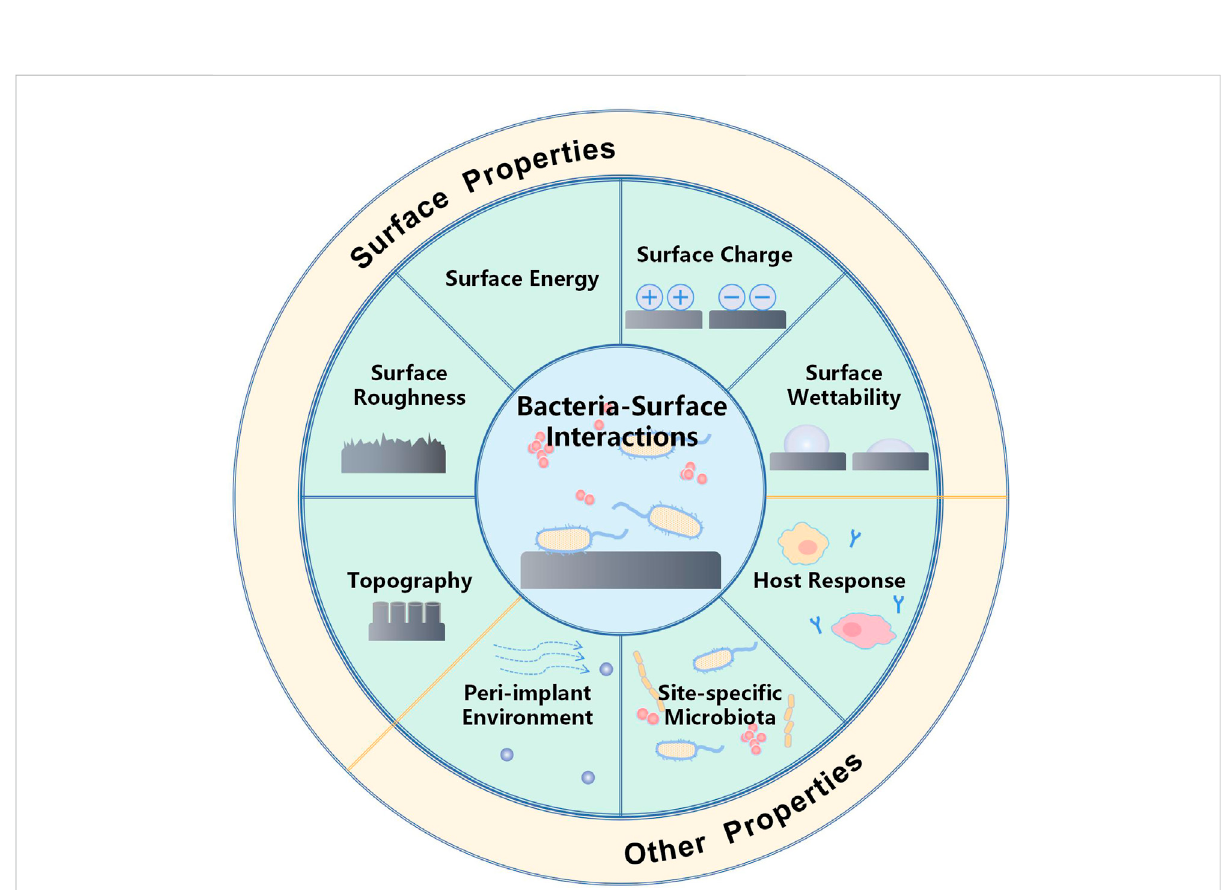
FIGURE 2 Schematicillustrationofvariousfactorsthatin fl uencebacterialadhesion.Bacterialadhesionisgovernedbydiversesurfacepropertiesincluding surface roughness, charge, wettability, and topography. Other factors, such as the peri-implant environment, site-speci fi c microbiota, and host response, can also affect bacteria-surface